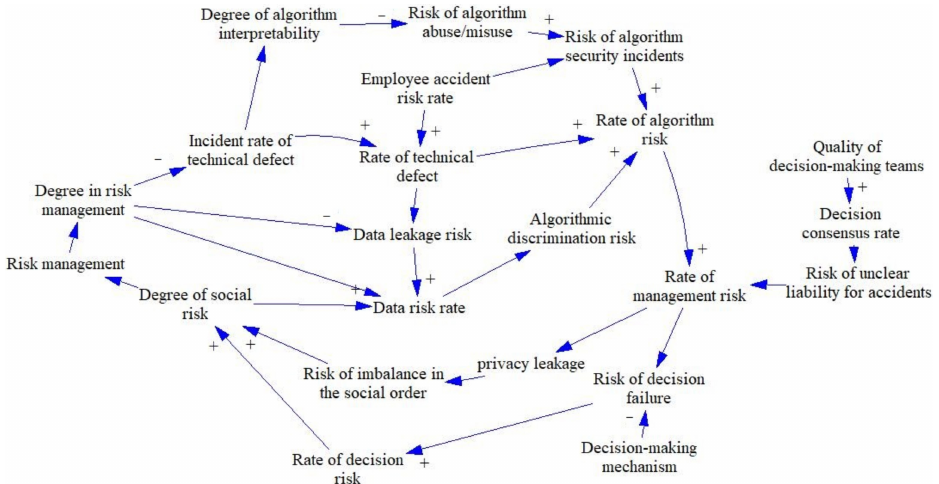
Figure 6. Risk management system causality diagram. Loop 3: degree in risk management (DRM) → DSR → ADR → RAR → RAR → data leakage risk (RDF) → RISO (RDF) → DSR → risk management (RM) → DRM; Loop 4: DRM → incident rate of technical defect (IRTD) → rate of technical defect (RTD) ( → data leakage risk (DLR) → DSR → ADR) → RAR → RAR → RDF (DLR) → RDF (RISO) → DSR → RM → DRM; Loop 5: DRM → DLR → DSR → ADR → RAR → RAR → RDF (DLR) → RDF (RISO) → DSR → RM → DRM; Loop 6: DRM → IRTD → degree of algorithm interpretability (DAI) → risk of algorithm abuse/misuse (RA A/M) → risk of algorithm security incidents (RASI) → RAR → RAR → RDF → RDF → RM → DRM. Note: “Underline” indicates the simultaneous alternative